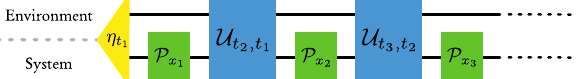
FIG. 2. General open quantum process. The state of the system at time t 1 is correlated with the environment (depicted by the yellow triangle representing the joint state). Measurements on the system (green boxes) are performed at times t 1 ; t 2 ; … . In between, the system and the environment undergo a unitary evolution (blue boxes). The distinction between system and environment is given by the degrees of freedom that the experimenter controls (system) and those that remain inaccessible to experimental control